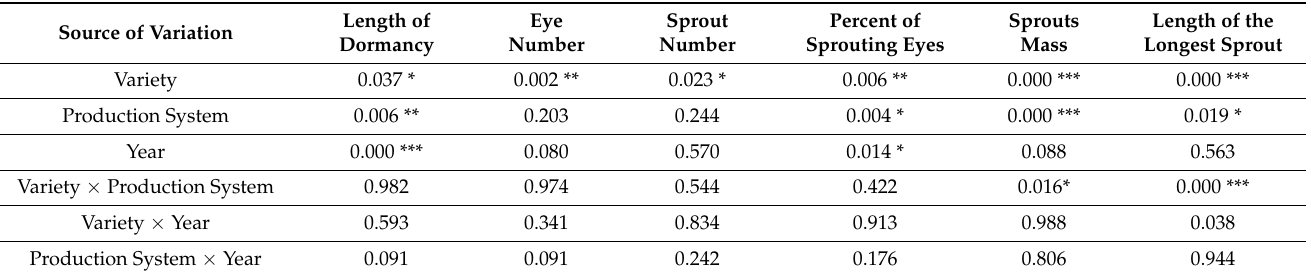
Table 4. Sources of variation, ANOVA results, and levels of significance ( p -values) for treatments affecting tested parameters—tuber